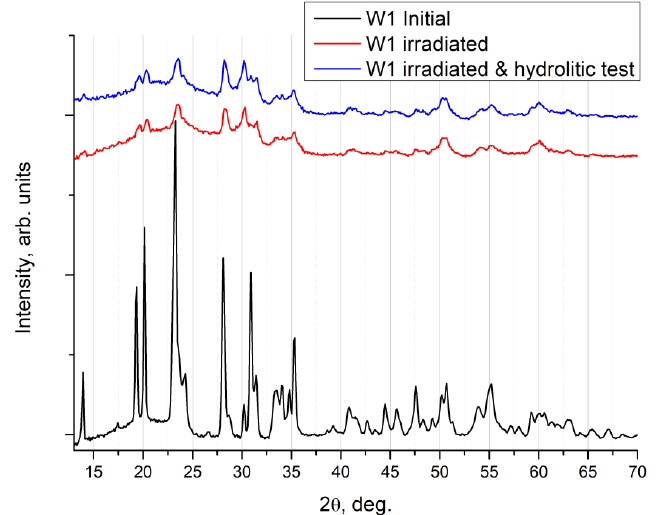
Figure 12. XRD patterns for the Na 0.5 Zr 2 (PO 4 ) 2.5 (WO 4 ) 0.5 ceramic specimen: initial state, irradiated with Xe ions at a dose of 3·10 12 cm − 2 , and after hydrolytic tests.